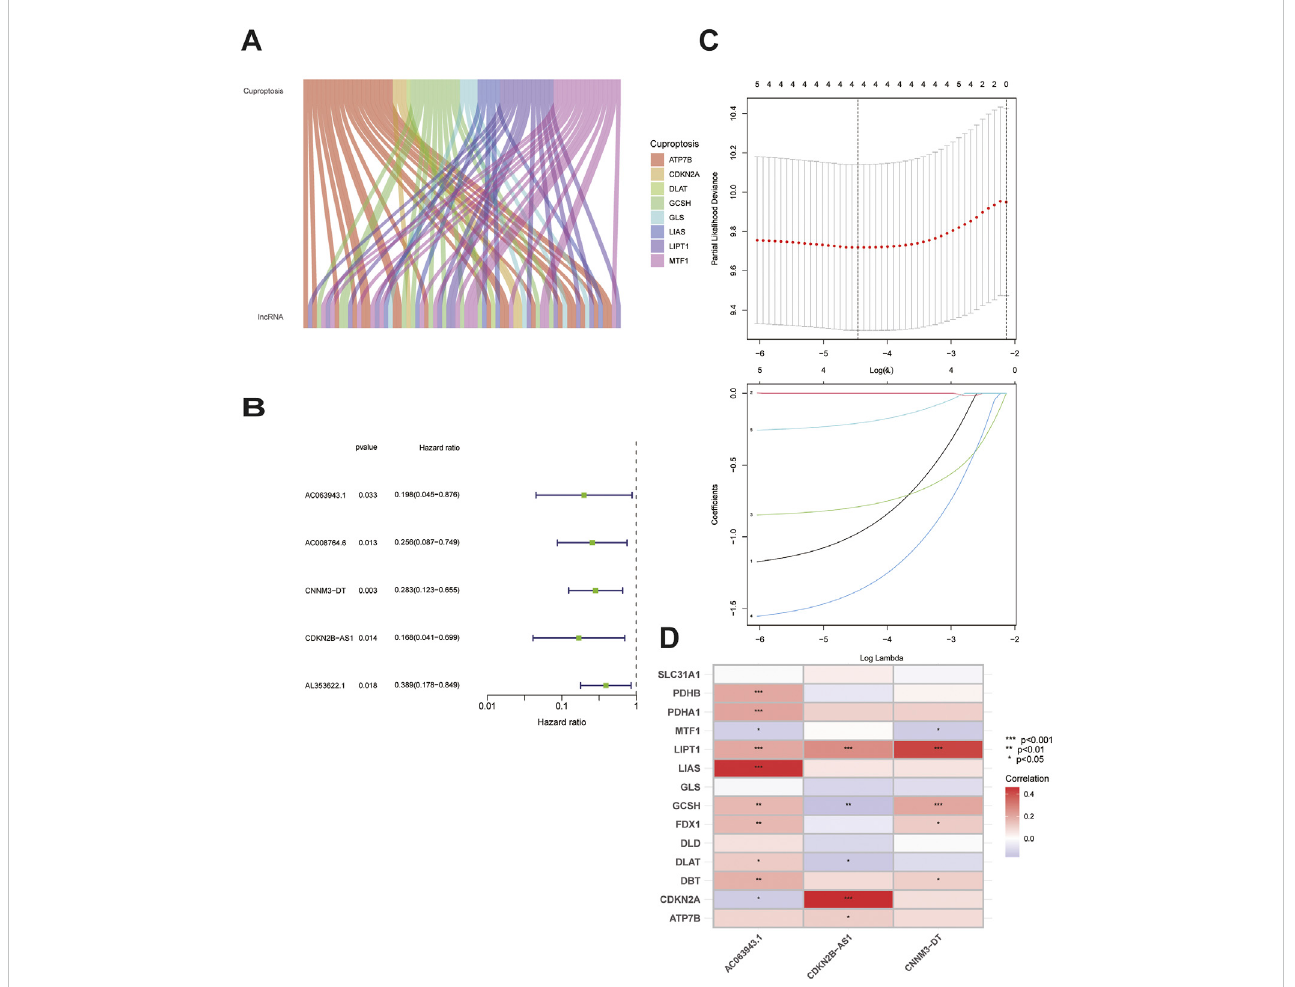
FIGURE 1 Identi fi cation of the signature of cuproptosis-related lncRNA. (A) Sankey diagram of 71 lncrnas co-expressed with cuproptosis-related genes. (B) Forest plots of 5-lncRNA screening by COX regression related with cuproptosis. (C) Lasso regression of the 5-lncRNA. (D) Heatmap shows the co-expression relationship between cuproptosis-related lncRNA signature and cuproptosis-related